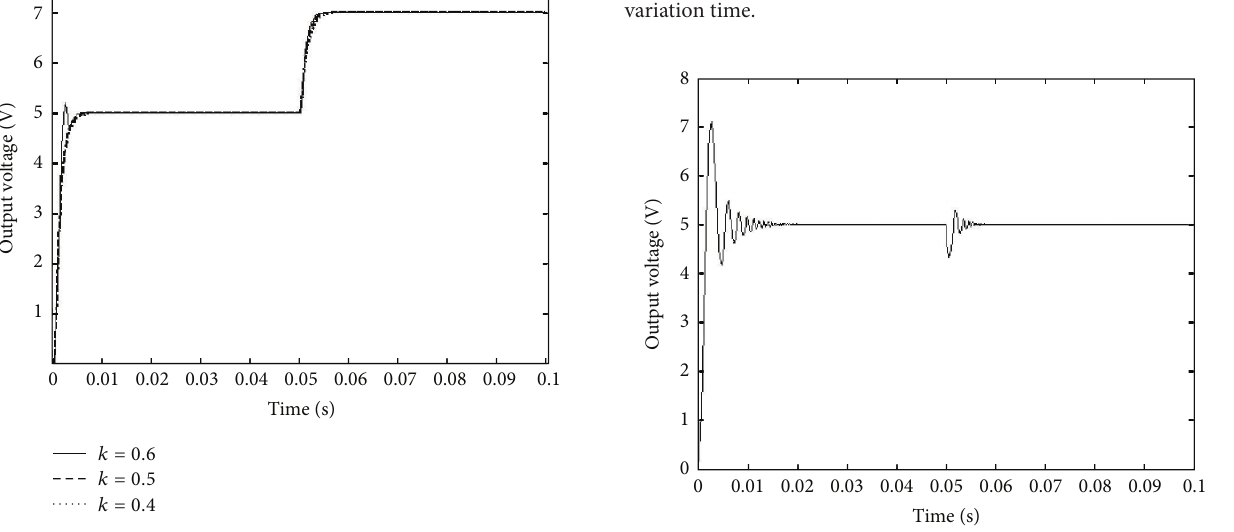
Figure 8: The DC/DC output voltage for a step change in reference voltage with respect to different values of 𝑘 in indirect control method.